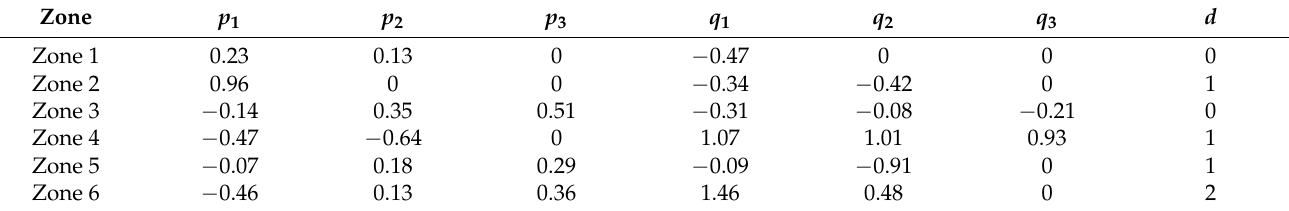
Table 4. Parameter of ARIMA model.